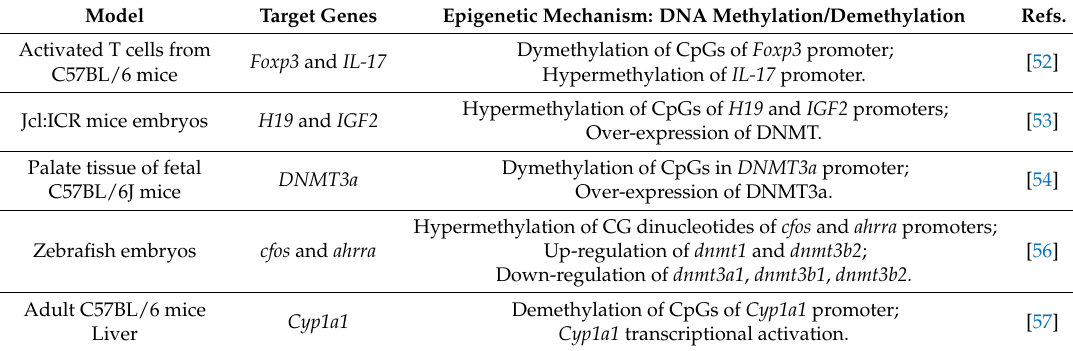
Table 1. Summary of the recent papers dealing with new insights in TCDD-induced epigenetic Methylation/Demethylation of target